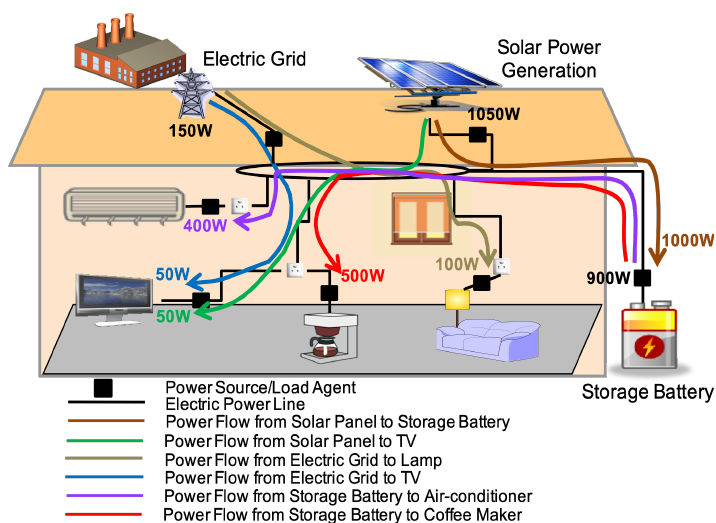
Figure 1. The concept of The Power Flow Coloring.